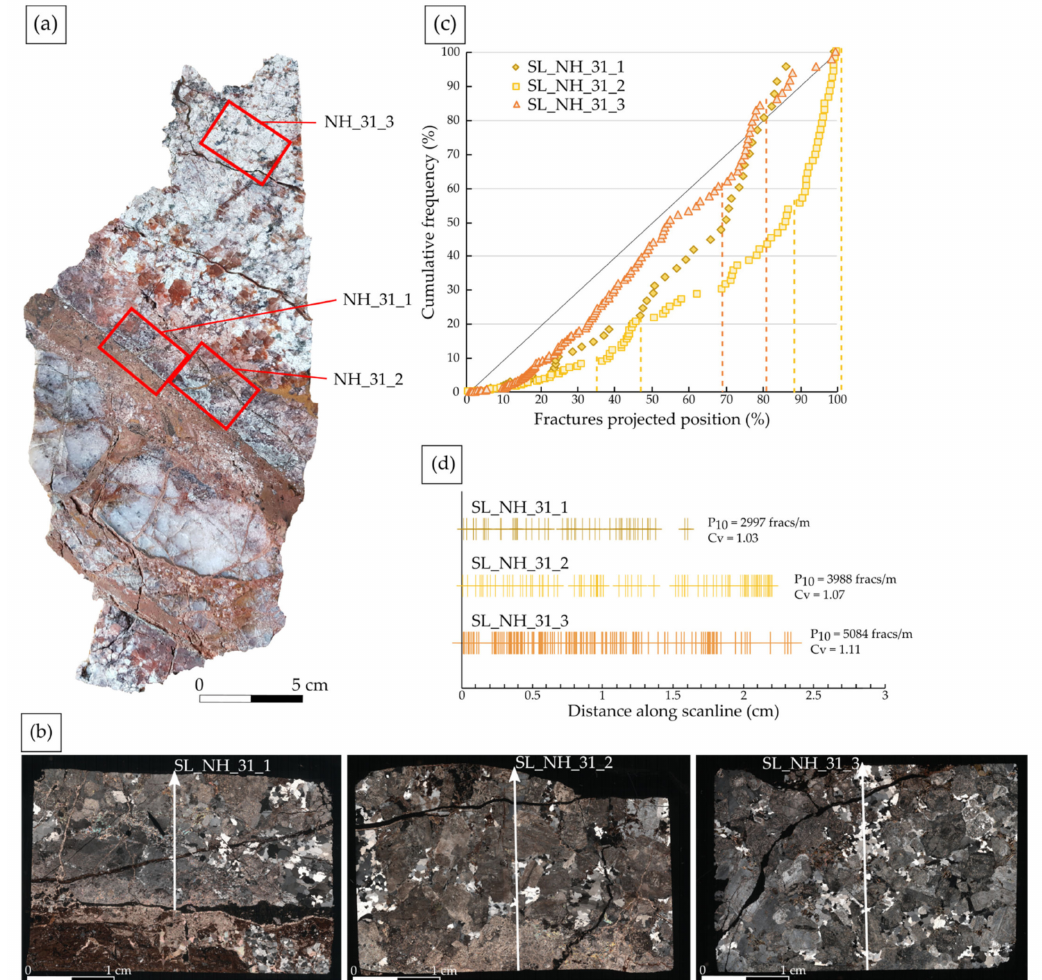
Figure 8. ( a ) Thin sections location on the sample NH_31. ( b ) Thin section mosaics showing the position and orientation of the scanlines. ( c ) Plots of the cumulative frequency percentage against distance percentage for each scanline. The diagonal represents a uniform distribution. Dashed lines indicate a zone where a rapid increase of the number of fractures is observed (slope threshold >2). ( d ) Stick plots showing the position of the fracture along the scanlines and for which the fracture density (P 10 ) and the coefficient of variation (Cv) are